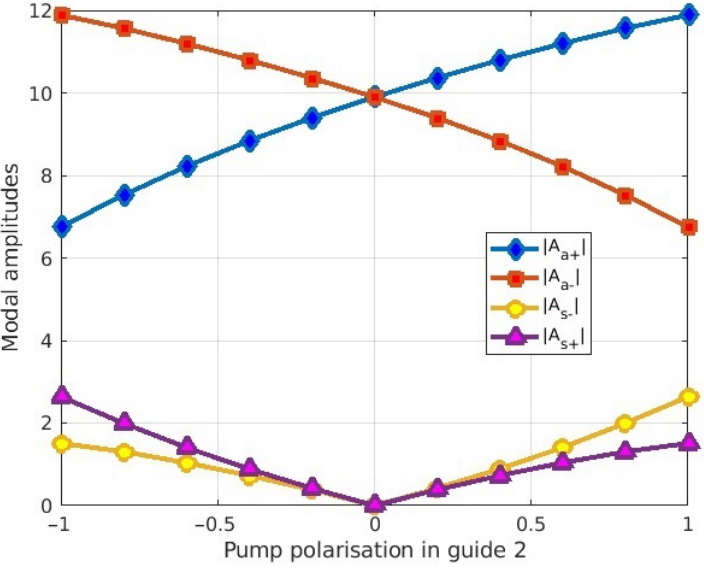
Figure 8. Variation of the normal mode amplitudes | A k , ± | against P ( 2 ) , the pump ellipticity in guide ( 2 ) , for P ( 1 ) = 0 and η ( i ) = η anti-symmetric